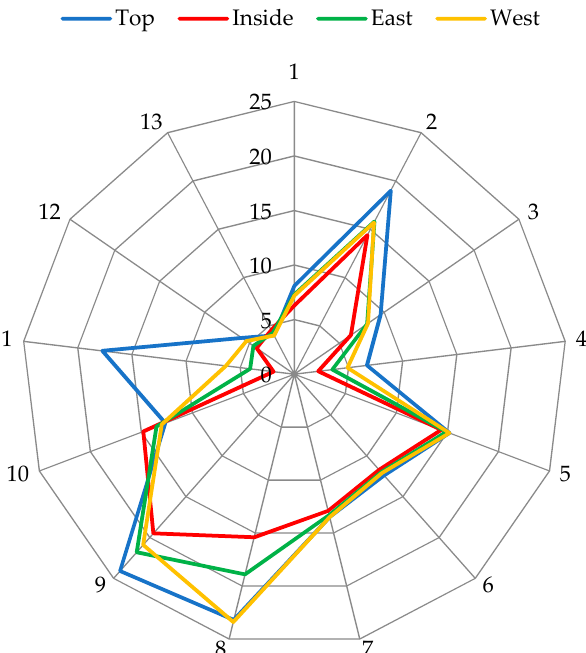
Figure 2. Effect of canopy position on the internal and external quality parameters of apple fruit, where 1—fruit yield, kg; 2—fruit weight, g (divided by 10 (/10)); 3—share of fruits with diameter >65 mm, % (/10); 4—fruit blush, % (/10); 5—dry matter content, %; 6—total sugar content, %; 7—soluble solid content, %; 8—sorbitol content, mg g − 1 DW; 9—total phenolic content, mg g − 1 DW (multiplied by 10); 10—total triterpene content, mg g − 1 DW; 11—total anthocyanin content µ g g − 1 DW (/10); 12—radical scavenging activity (TE ABTS , µ mol/g); 13—malic acid content, mg g − 1 DW (/10). Inside canopy leaves were distinguished by a significantly lower photosynthetic rate,